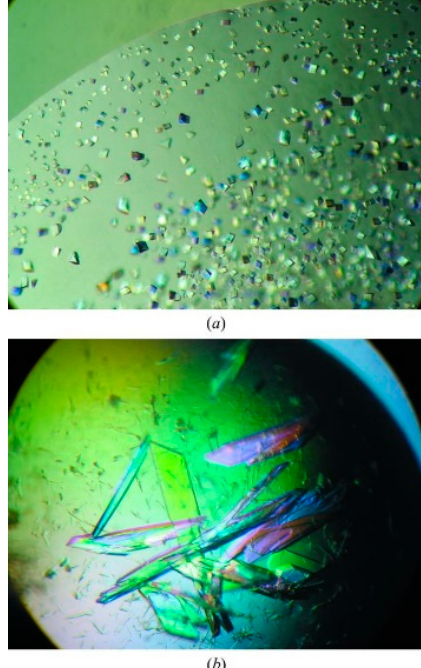
Figure 3. *MtCM crystals obtained by transfer from higher to lower precipitant concentration. ( a ) Control ( b ) after transfer [23].